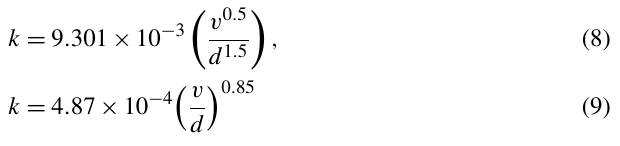
et al., 2012; Bourke et al., 2014a), which has the advantage of estimating k for the river being studied. However, such mea- surements are generally made along small reaches of a river that may not be representative of the river as a whole. Addi- tionally, if the experiments were made at specific flow condi- tions, the gas transfer coefficients may or may not be